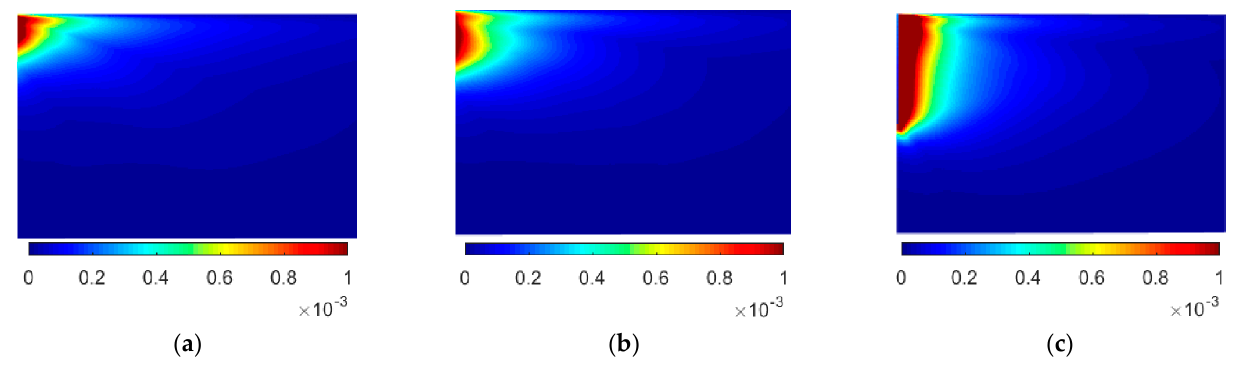
Figure 5. Octahedral shear strain in a homogeneous half space (Vs = 120 m/s) due to impact pile driving for pile depths of ( a ) 2.5 m; ( b ) 5 m; ( c ) 10 m.